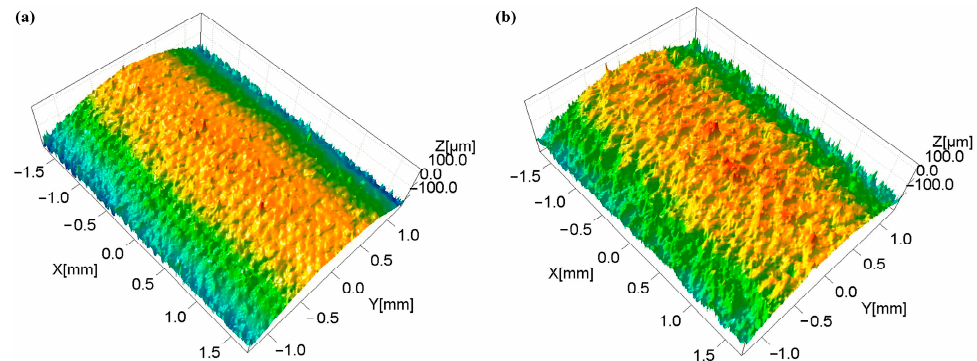
Figure 8. The outer three-dimensional shape of FeCrAl cladding in LPBF, ( a ) ring scanning and ( b ) bidirectional scanning.